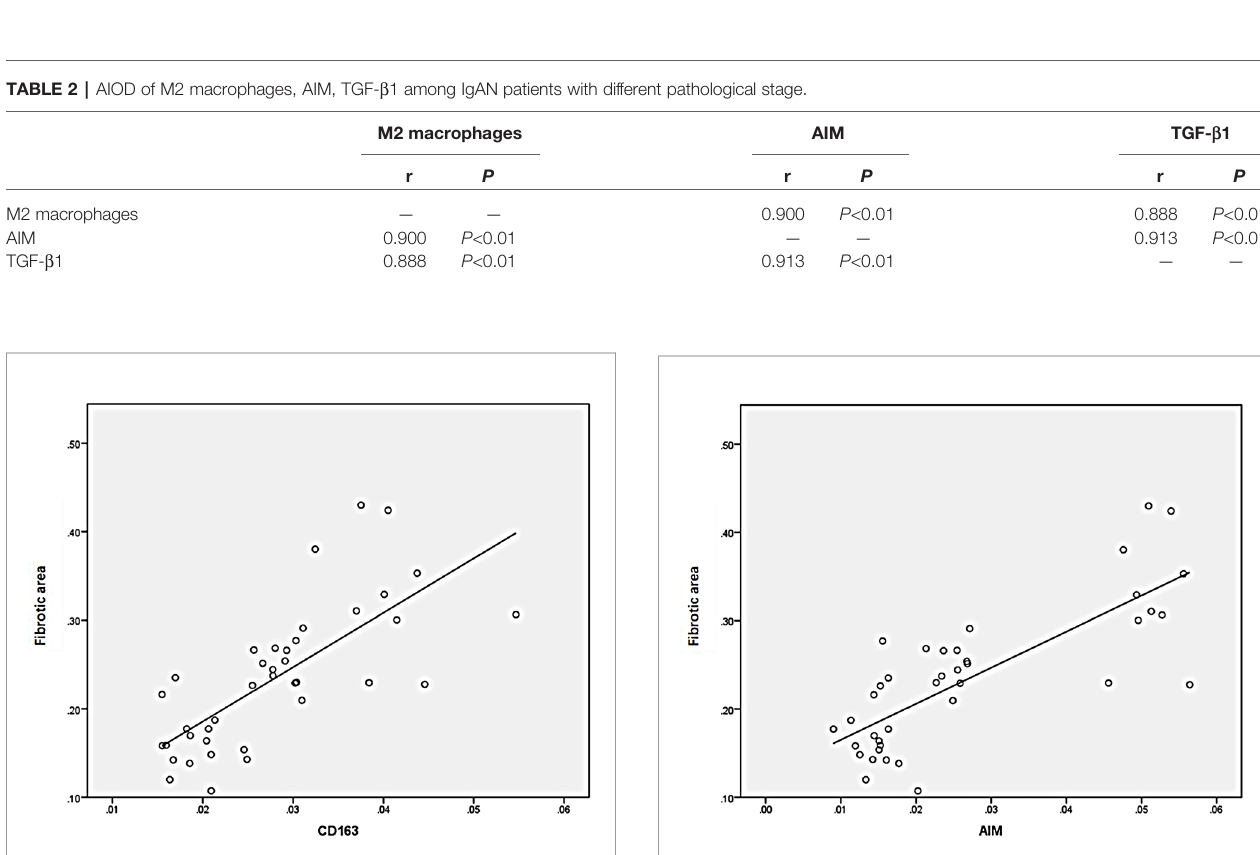
FIGURE 8 | AIM was positively correlated with fi brotic area (n=40, r=0.768,